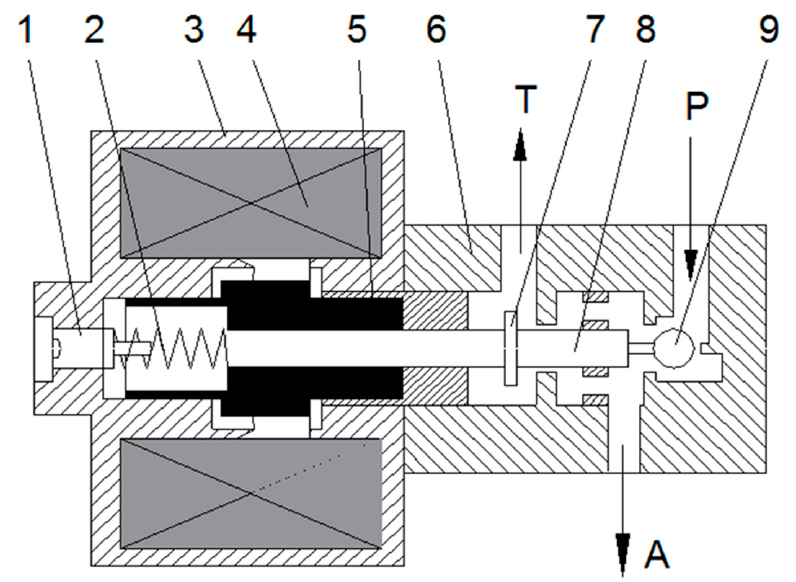
Figure 3. Structure diagram of shifting proportional solenoid valve. 1. Adjusting screw; 2. Adjusting spring; 3. Valve sleeve; 4. Coil; 5. Armature; 6. Valve body; 7. Valve baffle; 8. Spool; 9. Oil inlet ball valve.